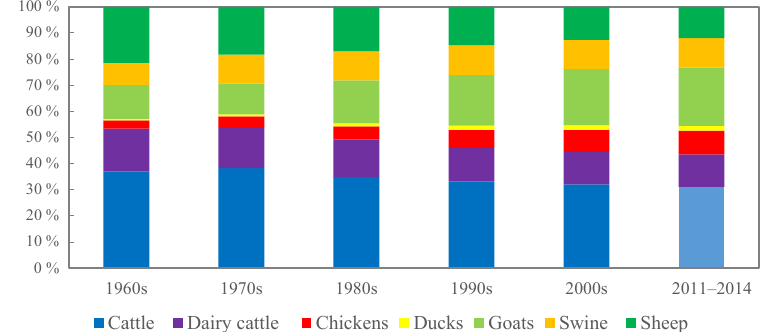
Figure 6. Relative contributions of different livestock animals to the total manure production.